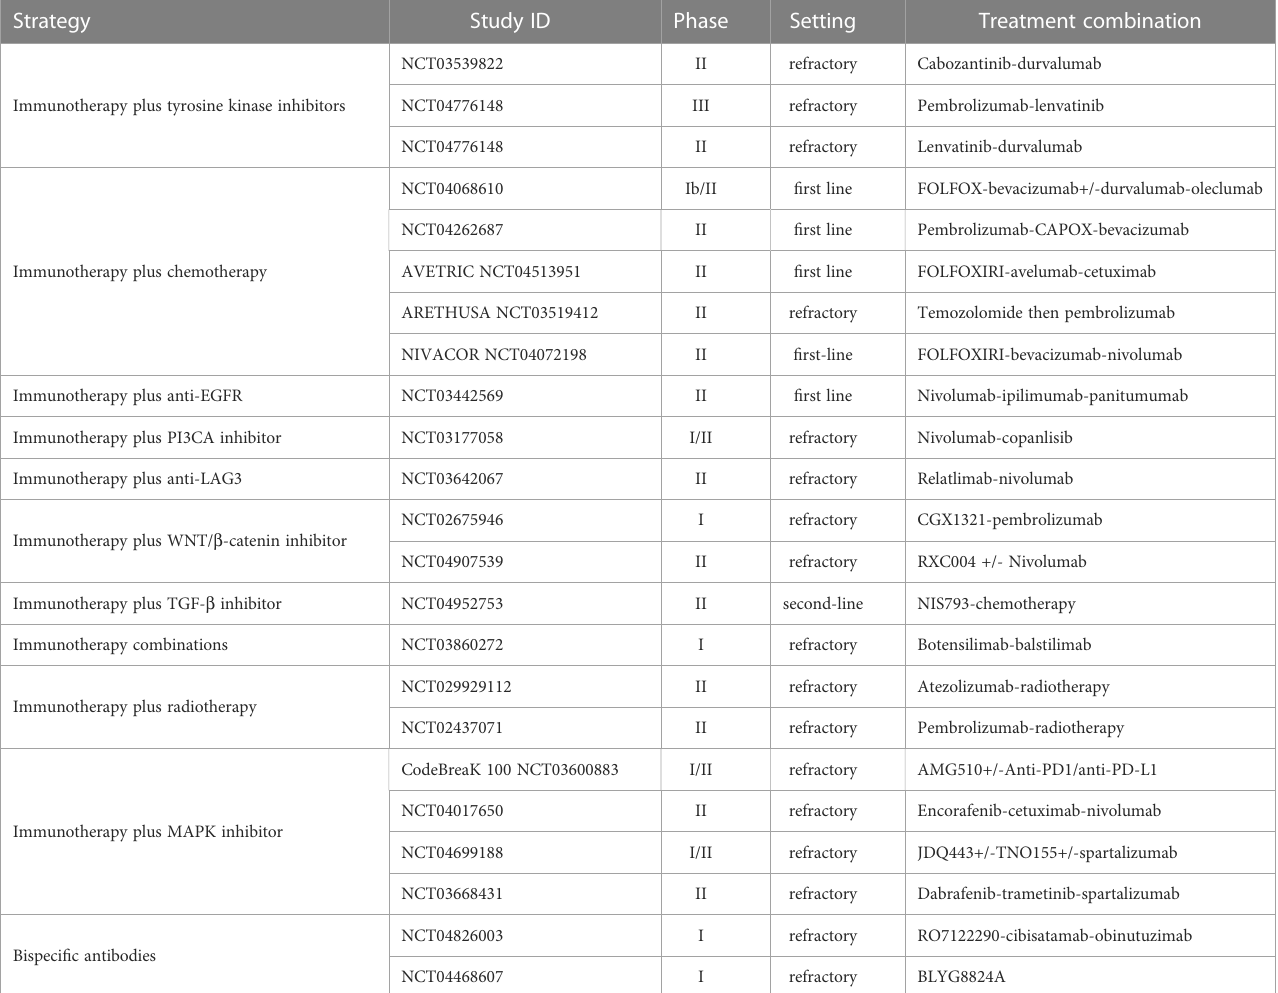
TABLE 2 Novel therapeutic strategies in ongoing clinical studies in MSS